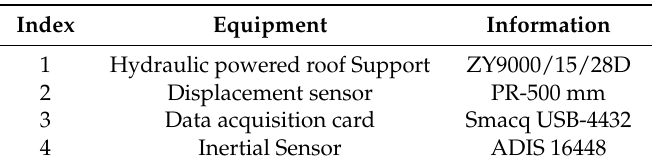
Table 4. Equipment configuration.